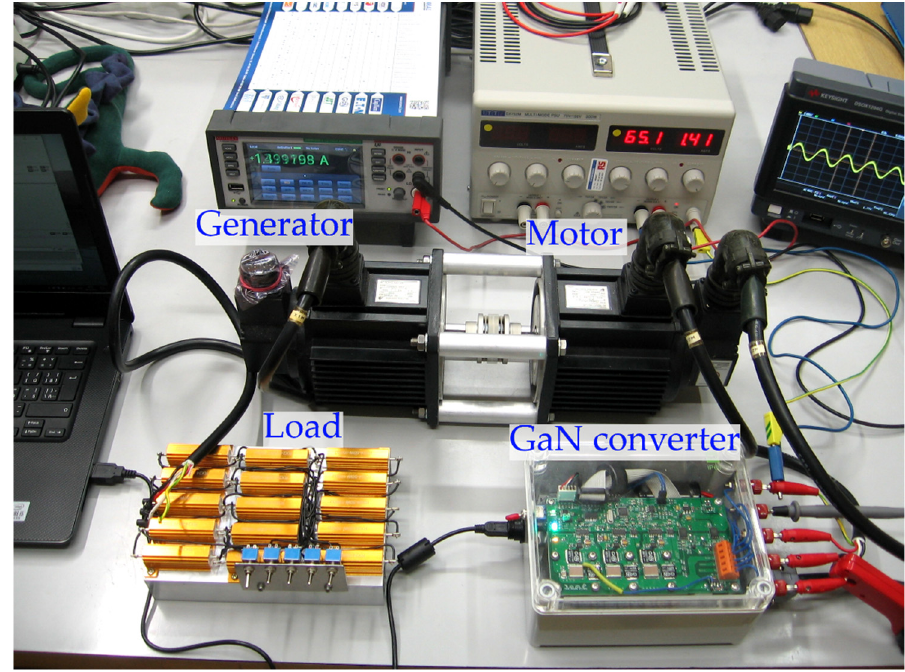
Figure 8. Experimental workplace.